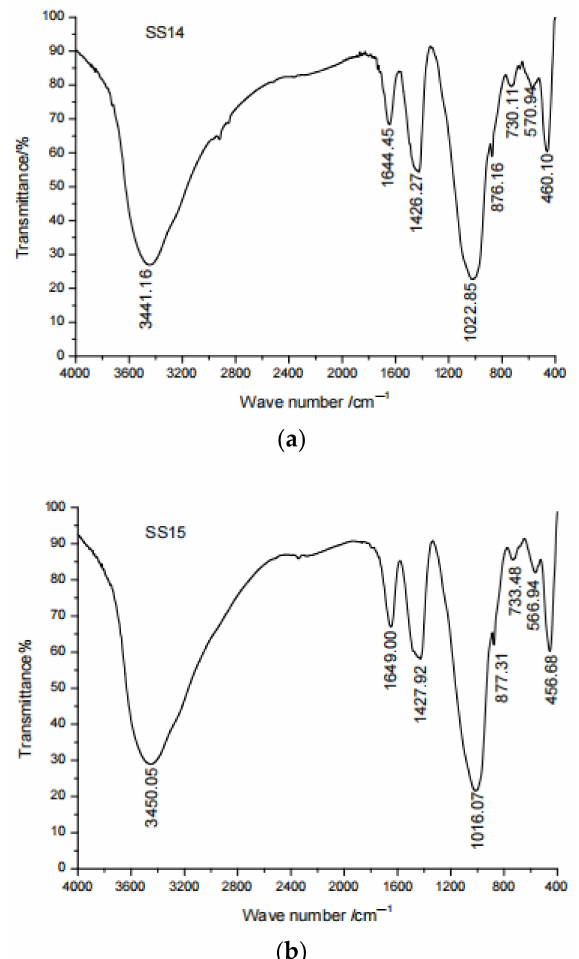
Figure 13. FTIR spectra of geopolymers after 28 days of curing. ( a ) SS14 ( b )